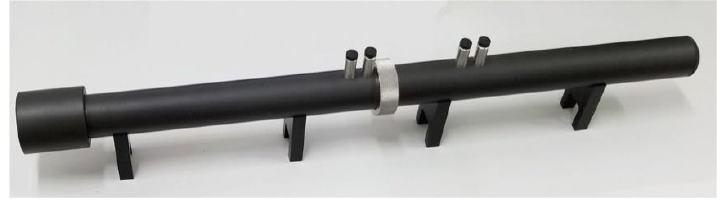
Figure 4. The impedance tube used in the experiments.